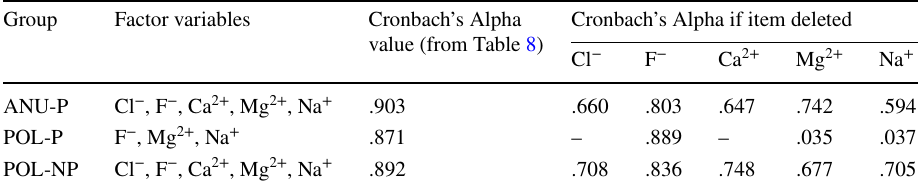
Group Factor variables